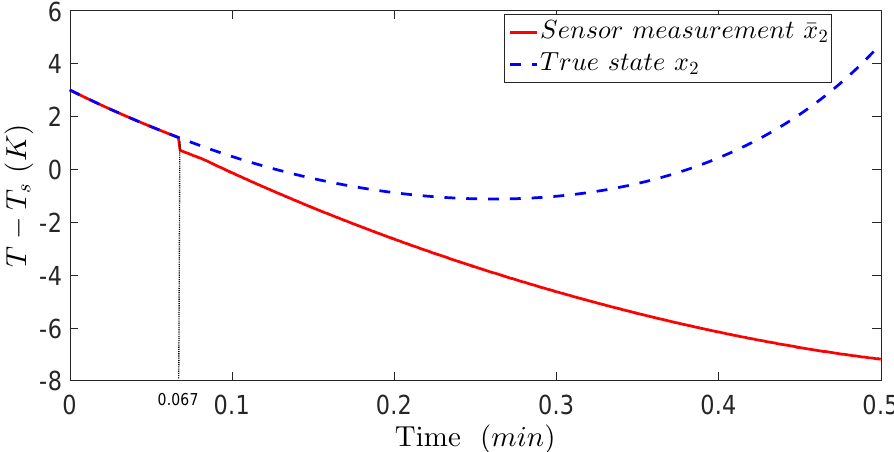
Figure 6. The true state profile ( x 2 = T − T s ) and the sensor measurements ( ¯ x 2 = ¯ T − T s ) of the closed-loop system under the LMPC of Equation (14) and under a min-max cyber-attack for the initial condition ( − 0.25, 3), where the vertical dotted line shows the time the cyber-attack is